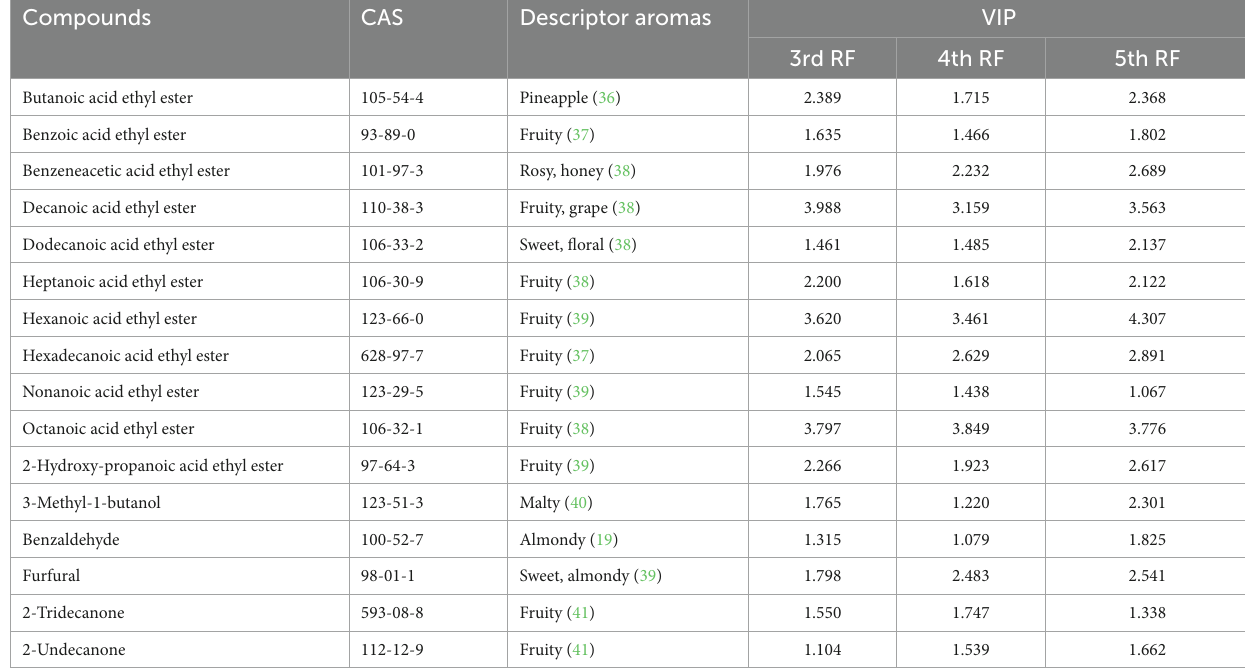
TABLE 1 Common differential compounds in different quality grades of base liquor of 3rd, 4th and 5th round of fermentation.